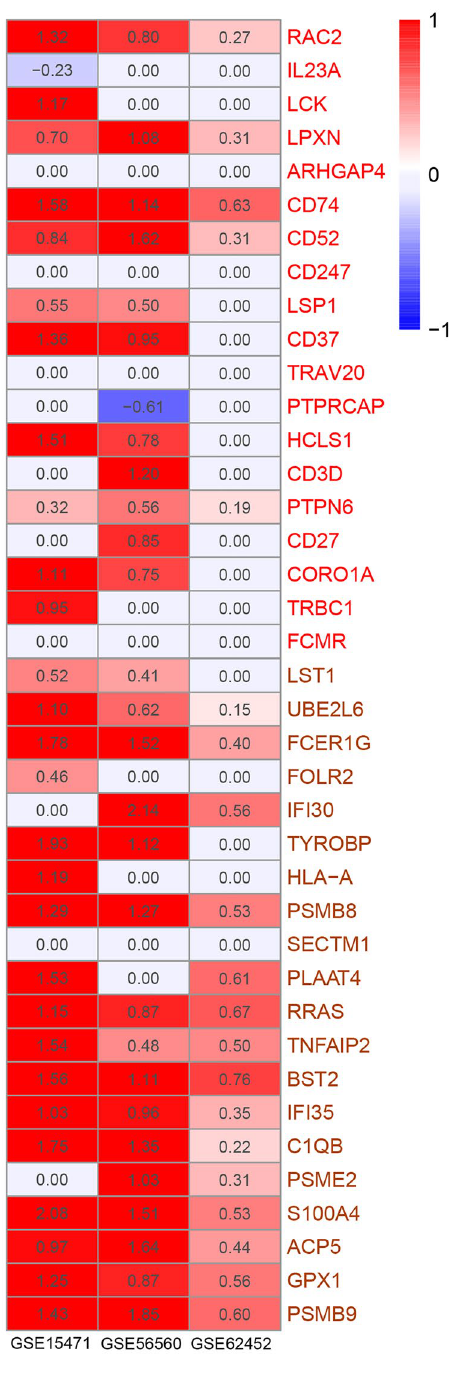
Figure 10. Up-regulation or down-regulation of genes in the data set GSE15471, GSE62452, GSE56560. Upregulated was marked as red ones. Downregulated was marked as blue ones. The white ones with number 0.00 indicate that the gene is not defined as a differentially expressed